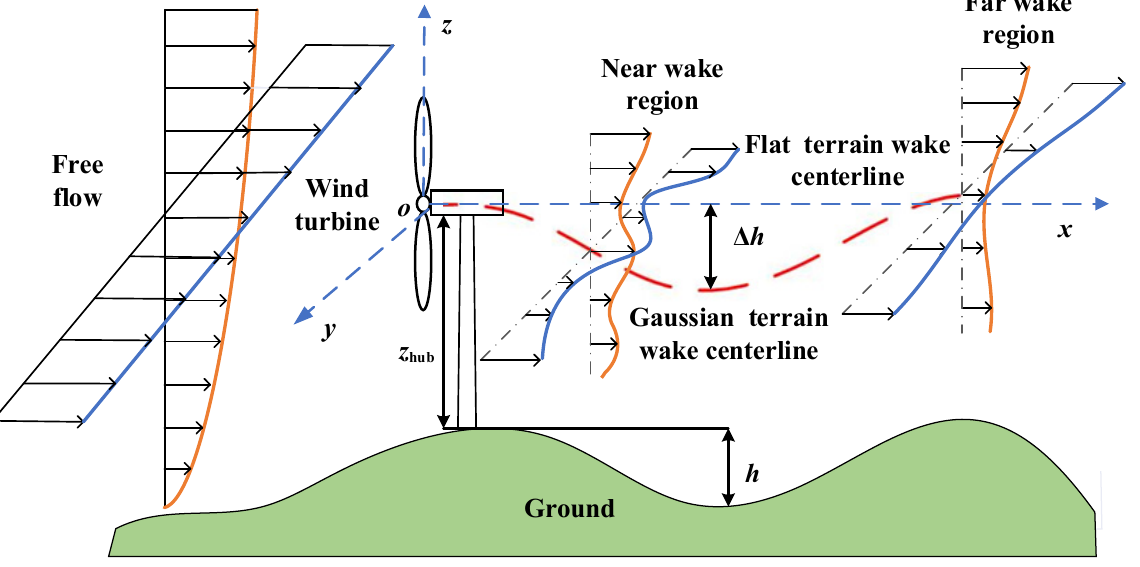
Figure 3. Schematic diagram of wind turbine wake center sinking on Gaussian